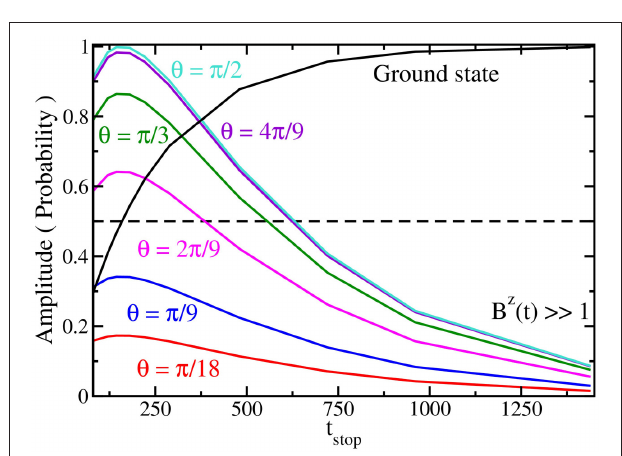
FIGURE 5 | Analysis of the amplitude of the oscillation for the Landau-Zener problem as a function of the t stop for 6 different θ ’s. The dashed line is when the ground-state probability is 0.5 . As θ increases to π/ 2 the amplitude scale increases as well. When the ground-state probability is near 0.5 the amplitude of the oscillations is maximized and the amplitude decreases when either the ground-state probability decreases or increases. Note the strong correlation between the increase of the amplitude of the oscillations and the decrease of the probability to be in the ground state when it is depleted from 100% to about 50%. Beyond this point, it becomes much more difficult to estimate, especially if experimental noise is included in the